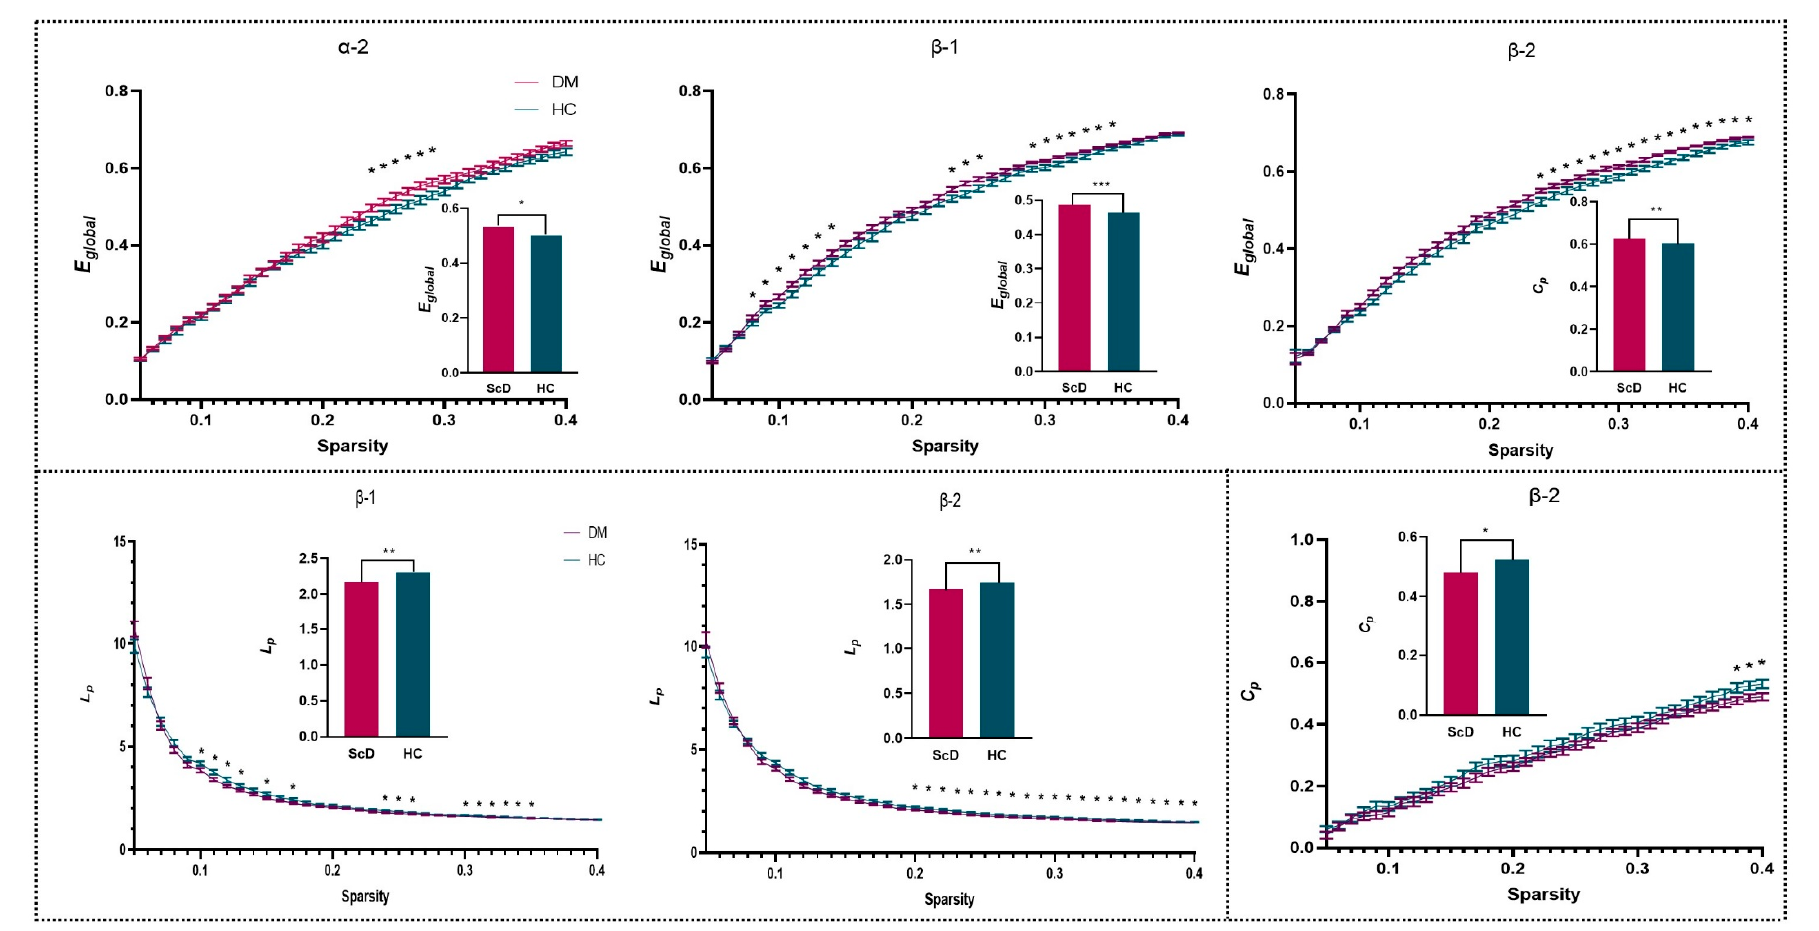
Figure 3. Topology properties of brain network based on sparsity threshold (0.05 < S < 0.4); the bar chart represents a comparison after averaging all thresholds with significant differences. * p < 0.05. ** p < 0.01.